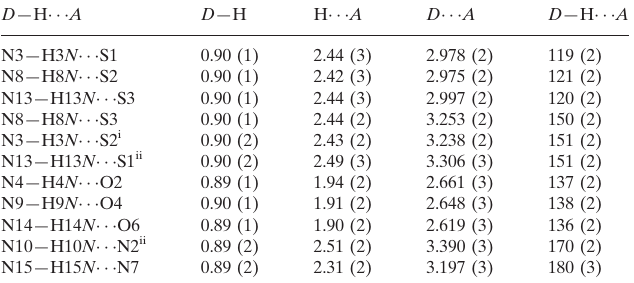
Hydrogen-bond geometry (A˚ , (cid:2)